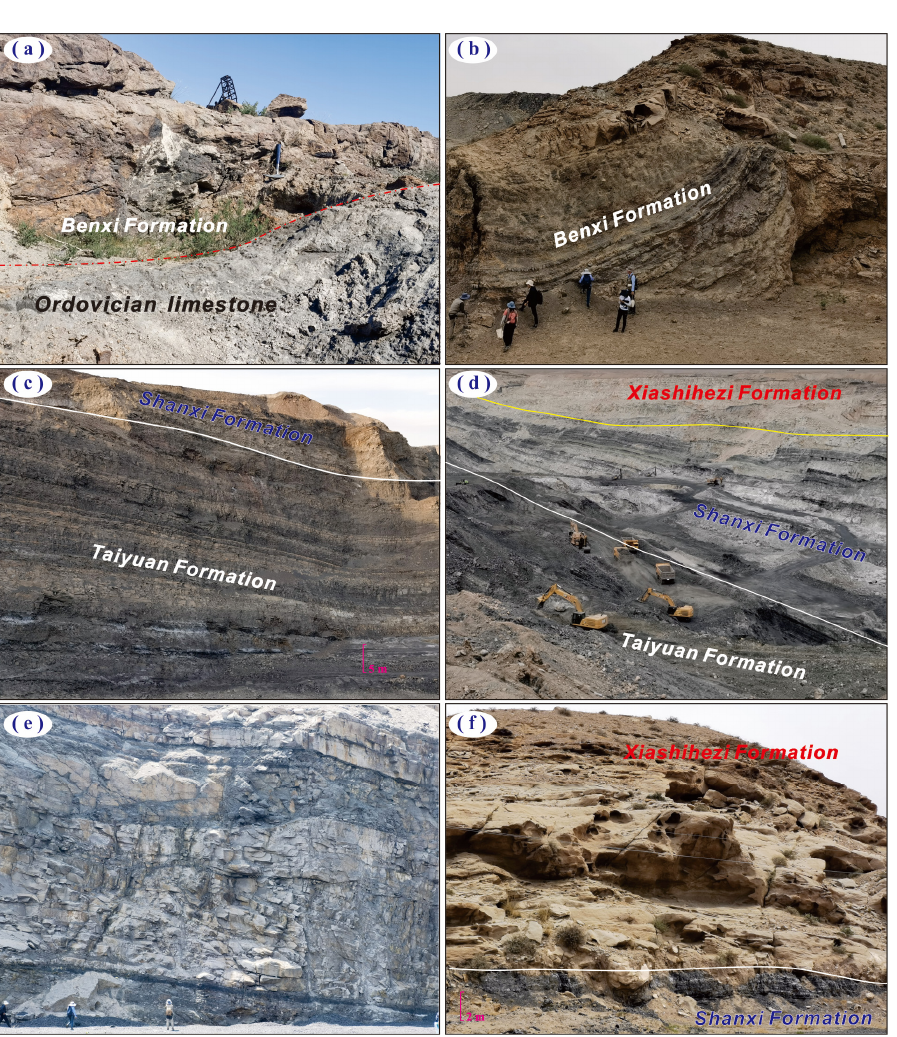
Figure 5. Representative photographs showing stratigraphy and sedimentology of Carboniferous and Permian strata in the Wuhai Coalfield. The positions of sections are labeled in Figure 2a. Scales include geologist (~170 cm tall), hammer (~30 cm long) and car (~3 m wide). ( a ) Paraconformity separating the underlying Ordovician limestone from the overlying sandstone of the basal Benxi Formation at the Kabuqi Section. ( b ) Alternation of quartz sandstone and coal ‐ bearing mudstone of the basal Benxi Formation at the Qilishan Section. ( c ) Overview of the Tiayuan Formation and lower Shanxi Formation, highlighting tidal flat facies characterized by alternation of sandstone and mud ‐ stone at the Kabuqi Section. ( d ) Distant view of the Taiyuan, Shanxi, and Xiashihezi formations at the eastern Zhuozishan. ( e ) Thick bedded sandstone of the Shanxi Formation at the Kabuqi Section. ( f ) Thick sandstone depositionally resting upon coal bed of the uppermost Shanxi Formation at the Qilishan Section.